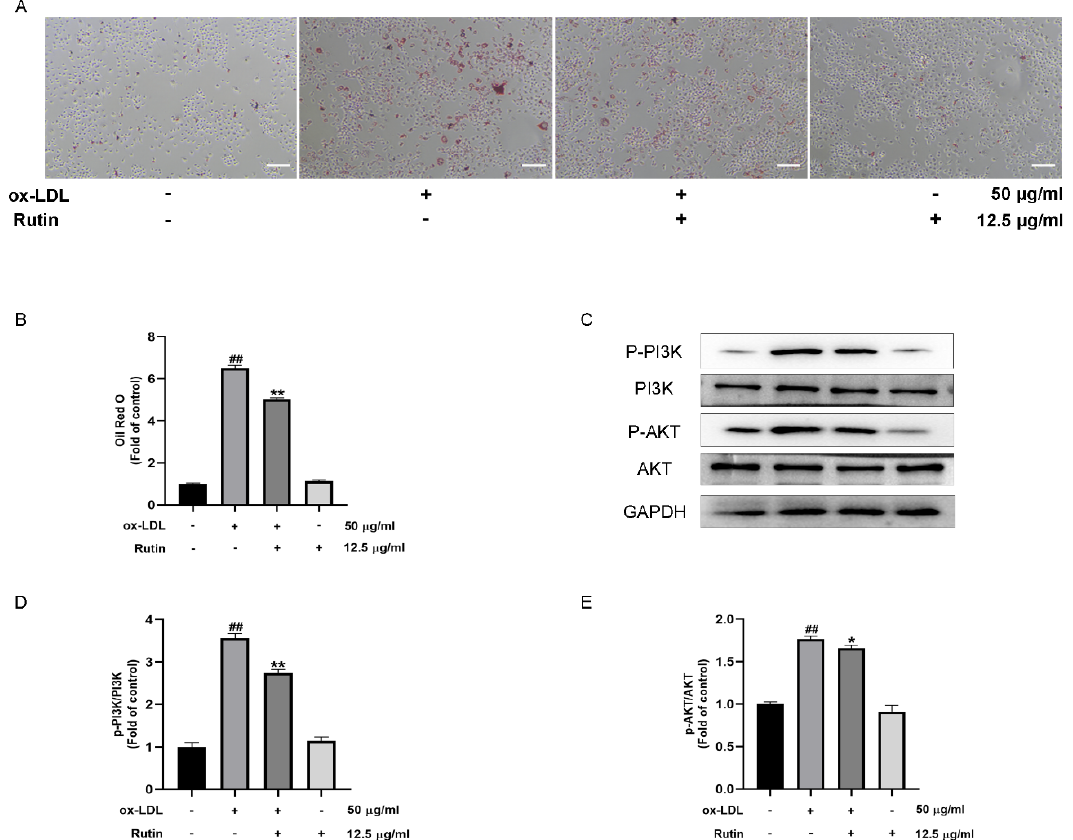
Figure 4. Rutin suppresses the PI3K/AKT signaling pathway and ox-LDL-induced foam cell formation. RAW264.7 cells were stimulated for 24 h with 12.5 µ g/mL rutin with or without 50 µ g/mL ox-LDL therapy. ( A , B ) Oil red O staining (Scale bars = 100 µ m). ( C – E ) P-PI3K, PI3K, P-AKT, AKT expression. ## p < 0.01 vs. control group; * p < 0.05, ** p < 0.01 vs. ox-LDL-treated group. Data are presented as mean ± SD.